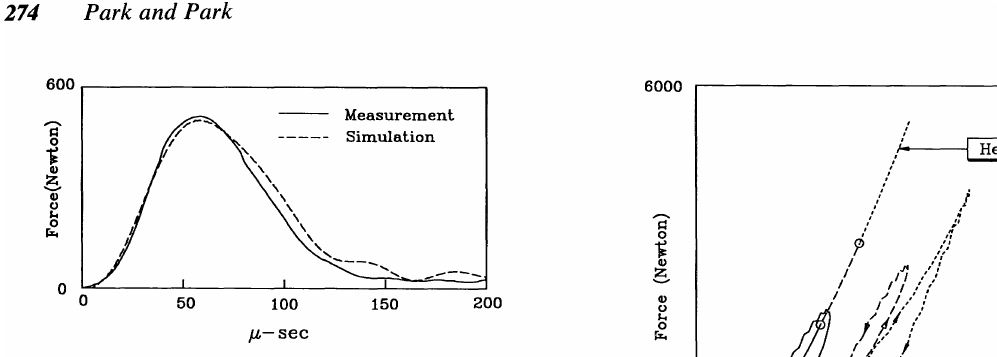
FIGURE 11 Measured and simulated force history at impact point.